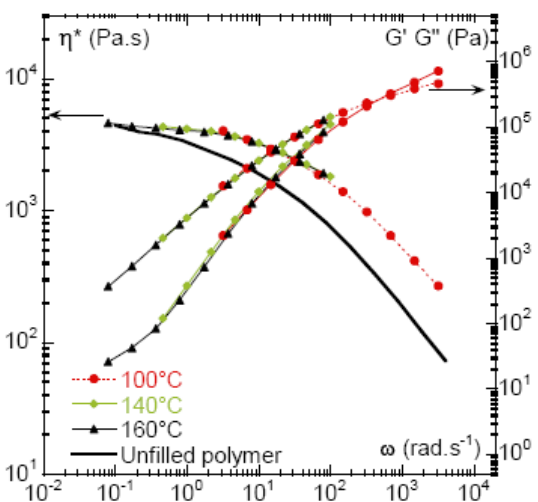
Figure 13. Time-temperature superposition of curves at 100, 140 and 160 °C for SPSFNa (IEC = 1.3 Na + /kg) + 40%PEG + 15% alumina fibers, Ref. temperature = 140 °C, unfilled polymer at 140